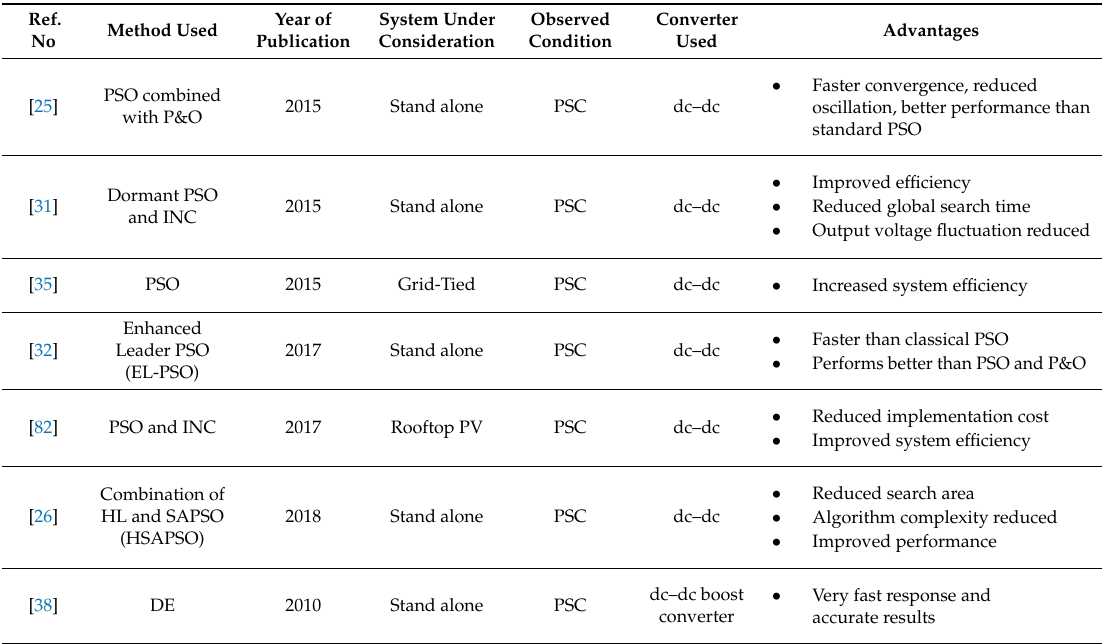
Table 2. Comparison of various algorithms used in the